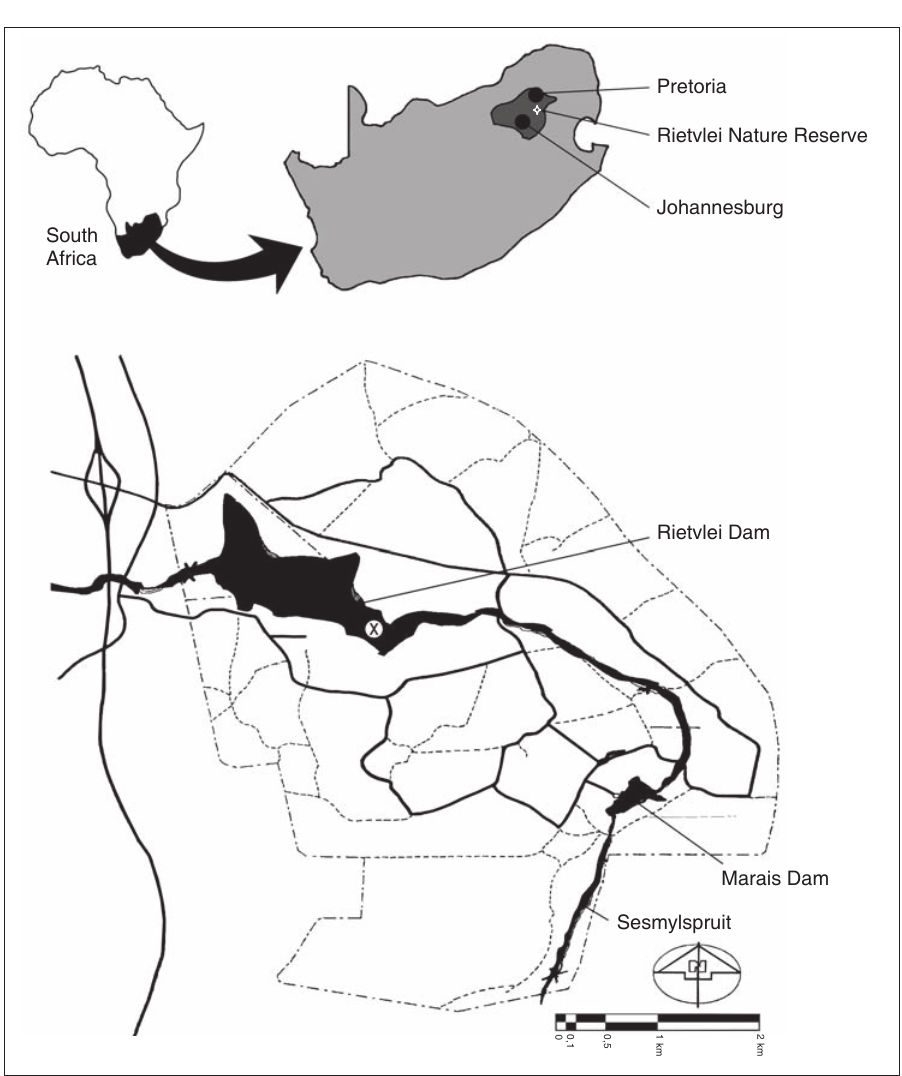
FIG. 1 The location of the Rietvlei Dam inside the Rietvlei Nature Reserve. X indicates point of sam- pling. Bar = 2 km